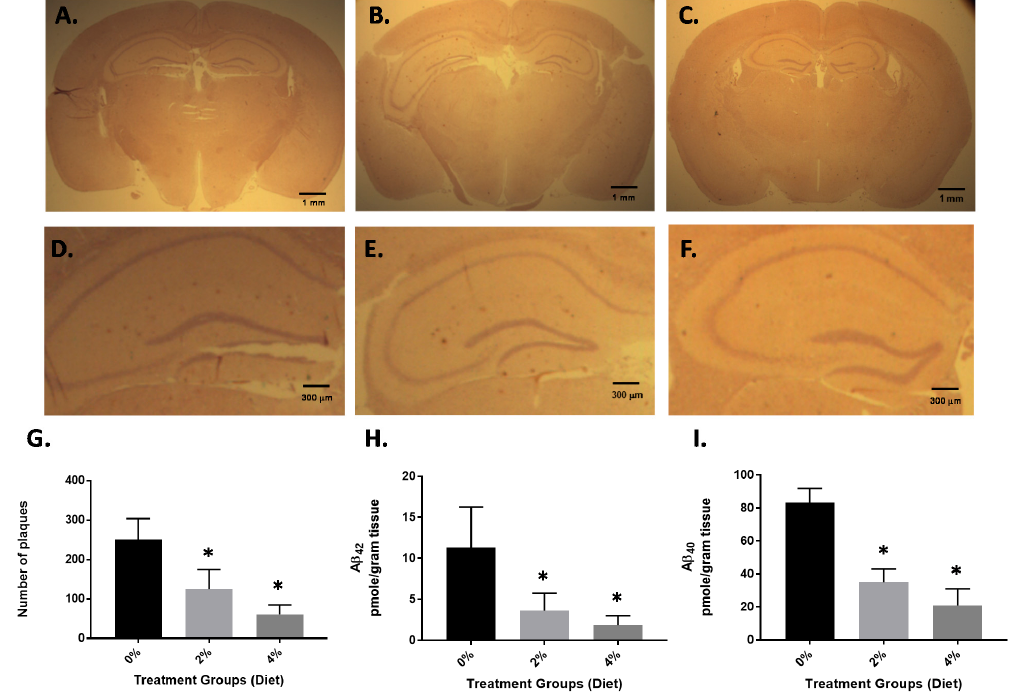
Figure 1. Amyloid load in APP/PS1 mice after 4 months of GF diet treatment. Brain hemisphere sections obtained from control mice ( A ) GF diet treated with 2% ( B ) or GF diet treated with 4% ( C ) were immunostained with mouse anti-human A β peptide (clone 10D5) antibody to detect amyloid plaques. Higher magnification ( D – F ). The number of amyloid plaques in the brain sections (15 sections per mouse) from each set of control mice or mice treated with GF diets were counted and averaged ( G ). The brain hemispheres were examined for guanidine-extractable A β 1-40 ( H ), and A β 1-42 peptides ( I ). Vehicle: 8-month-old APP/PS1-Tg mice that were not treated with GF diets were used as controls (* p < 0.001, n = 20 per